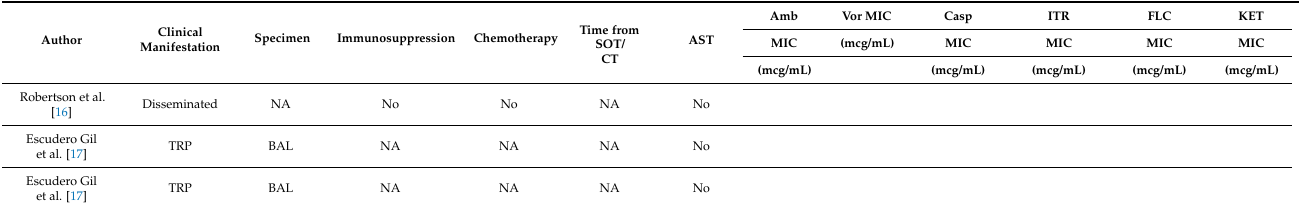
Table 2. Summary of diagnostic approach and antifungal susceptibility